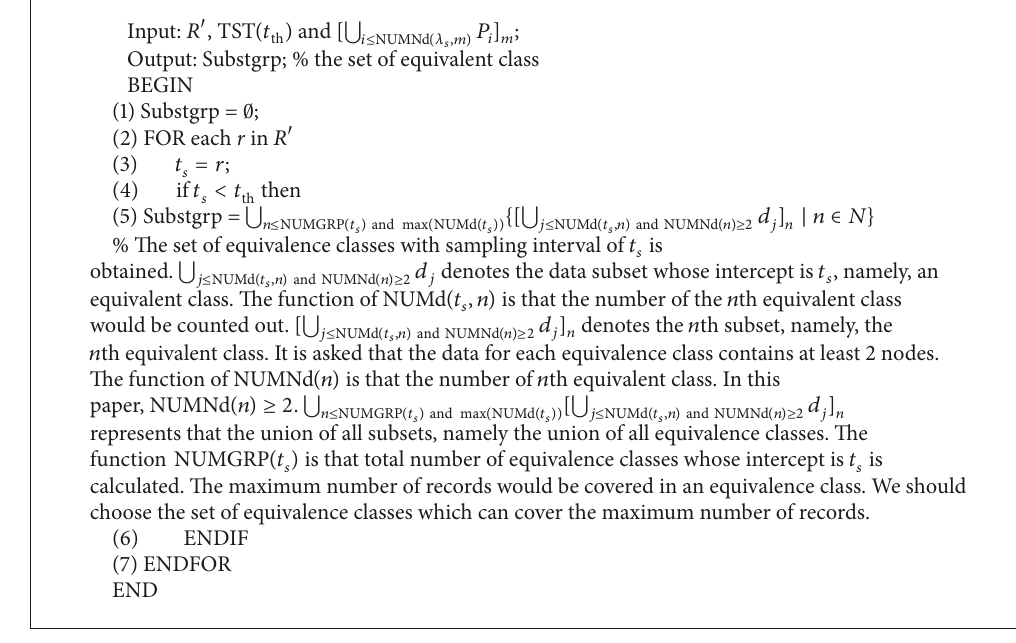
Algorithm 2: Sampling time clustering